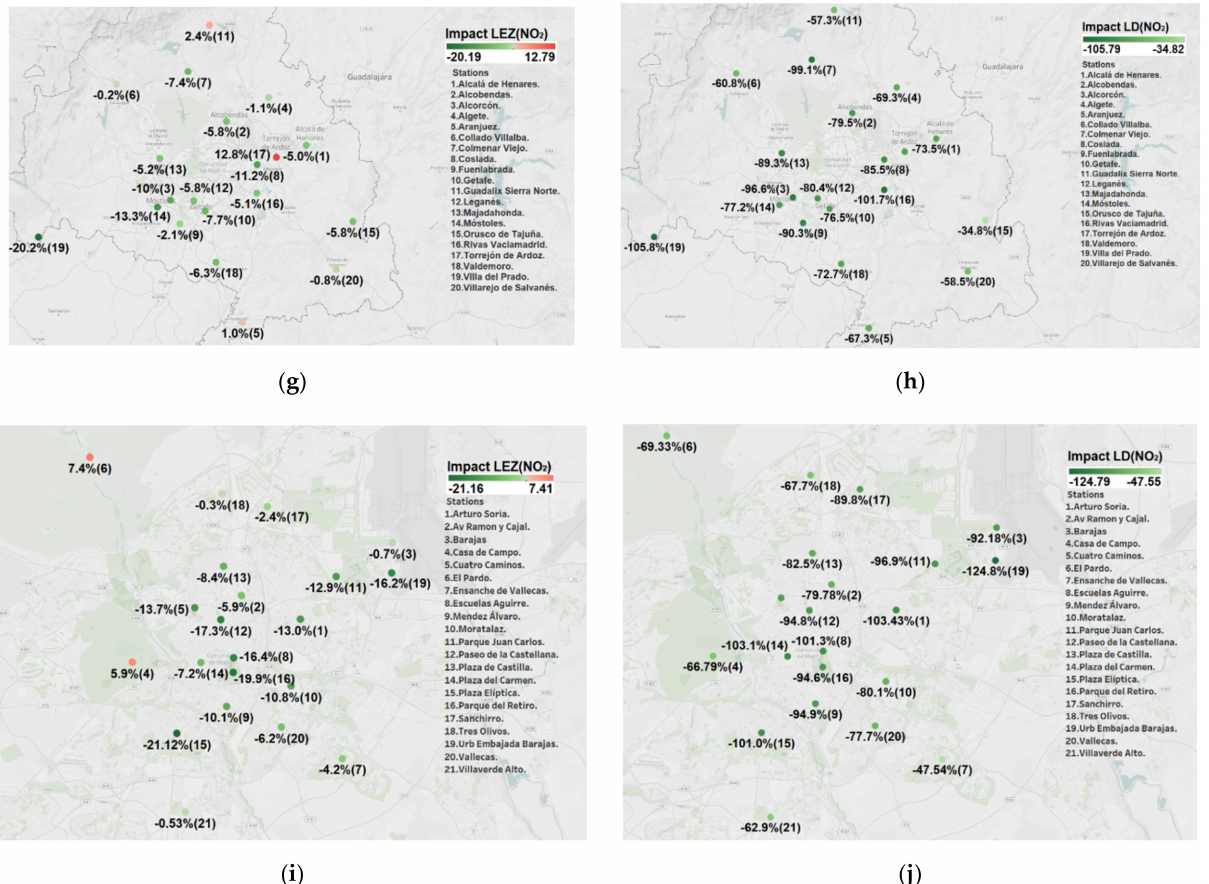
Figure 5. The left-hand side contains the estimates of the LEZ effect by monitoring station, while the right-hand side captures the LD effect on pollution within and outside Madrid city; ( a , b ) CO in CM, ( c , d ) NO in CM, ( e , f ) NO in Madrid city, ( g , h ) NO 2 in CM, ( i , j ) NO 2 in Madrid